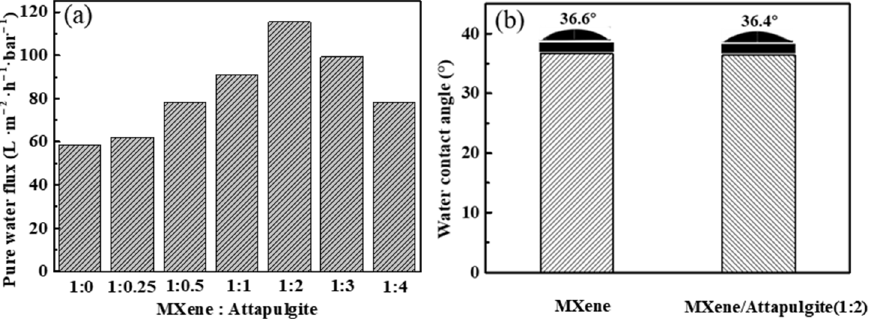
Figure 6. ( a ) Effect of mass ratio of MXene to attapulgite on the pure water flux of composite mem- branes; ( b ) water contact angle measurement of MXene and MXene/attapulgite composite (1:2) membrane.